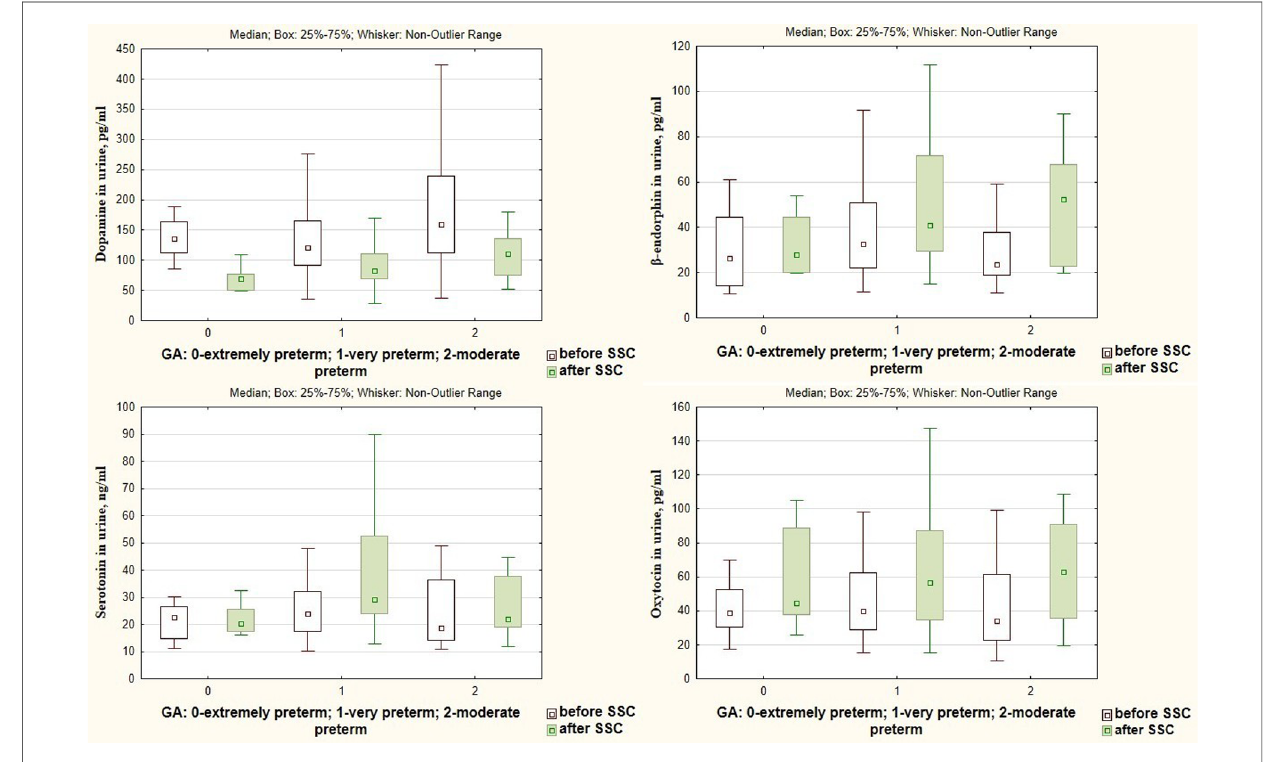
FIGURE 5 Dopamine, β -endorphin, serotonin, and oxytocin levels in urine before and after SSC in preterm infants of different gestational